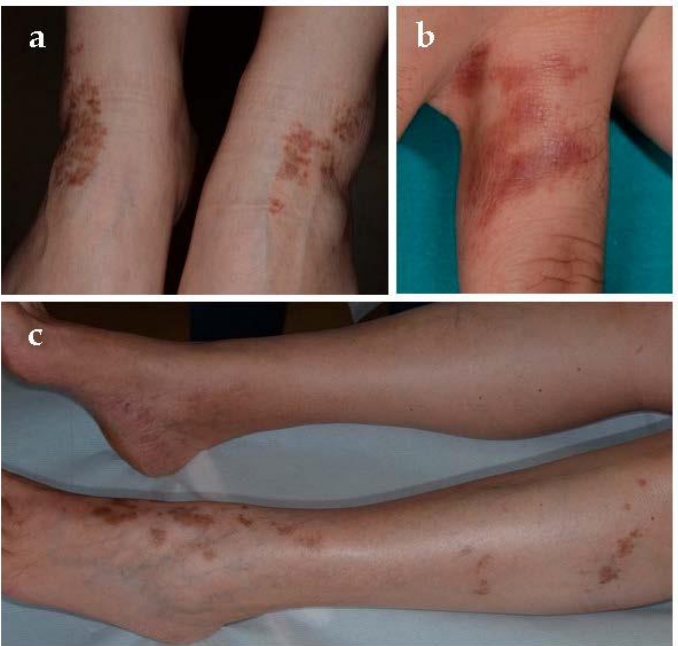
Figure 5. Lichen aureus. ( a ) Symmetrical and bilateral yellow-brown patches involving two malleoli. ( b ) Single localization of a rust-color patch on the first phalanx of the third finger. ( c ) Lichen aureus on the legs.